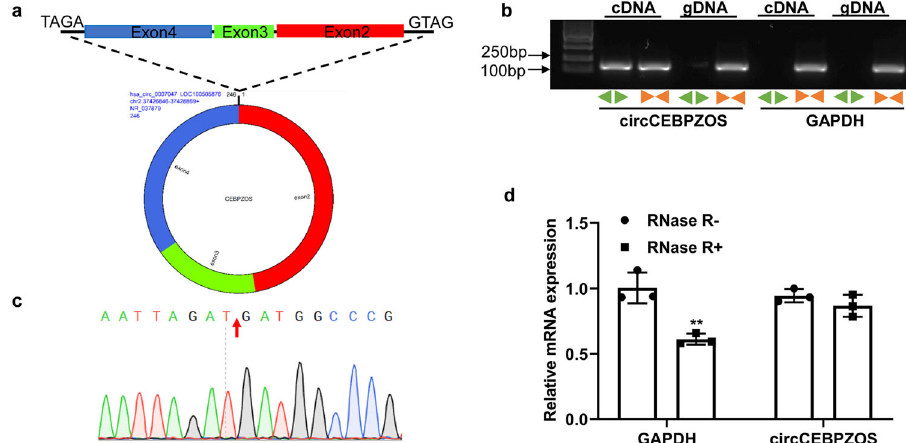
Fig. 2 Characteristics of circCEBPZOS. a Schematic diagram of the ring structure of circCEBPZOS. b Agarose electrophoresis assay to amplify the speci fi c products of circCEBPZOS from both cDNA and gDNA templates by using convergent and divergent primers. GAPDH served as a control. c Reverse shear site of circCEBPZOS was con fi rmed by Sanger sequencing of the ampli fi ed product of circCEBPZOS; d qRT – PCR was used to detect the expression of circCEBPZOS by using cDNA as a templates with the RNA digested by RNA exonuclease R before reverse transcription. GAPDH served as the negative control. Data are mean ± SD. ** P < 0.01, RNase R + group vs. RNase R-